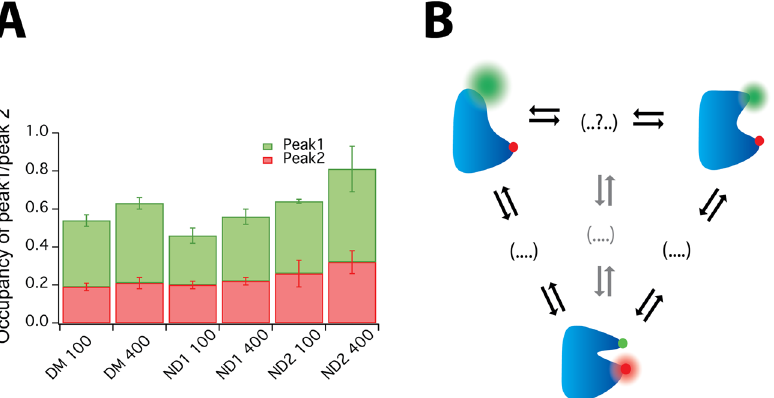
Figure 4. (A) Ratio of the occupancies of peaks 1 and 2 for POR in detergent micelles (DM) and nanodiscs (ND1 and ND2) as a function of ionic strength (B) An illustrative model of conformational sampling in